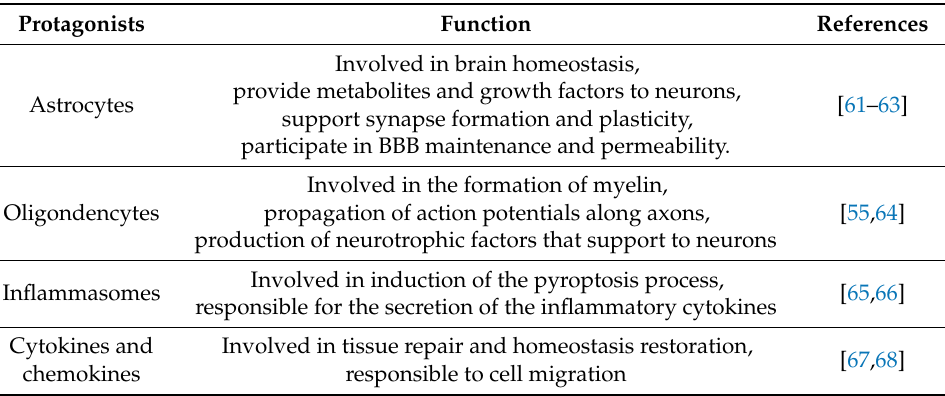
Table 4. Major protagonists involving during neuroinflammatory